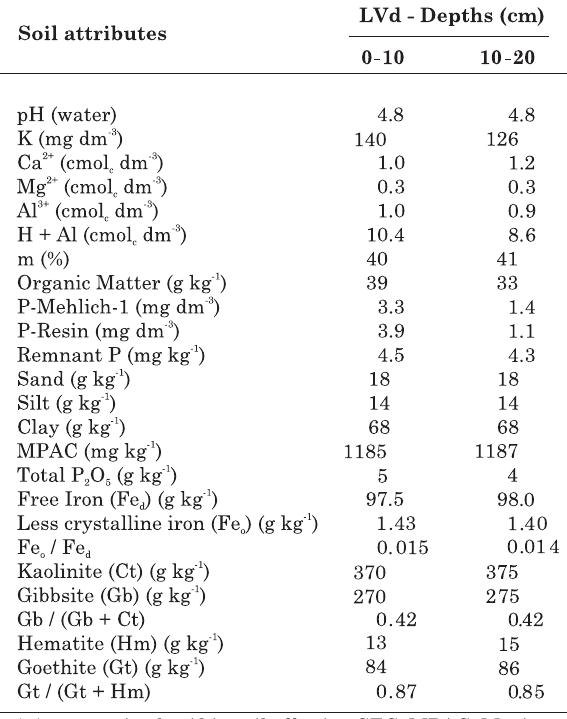
Table 1. Chemical and physical attributes of the dystrophic Red Latosol (Oxisol) at 0–10 and 10– 20 cm, prior to the